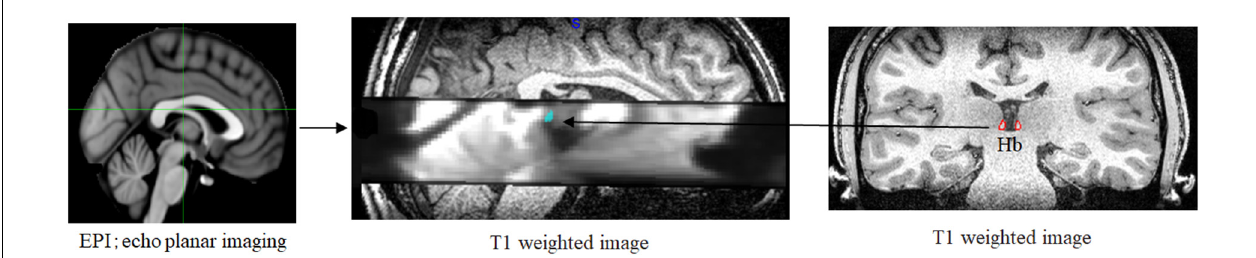
Frontiers in Human Neuroscience |